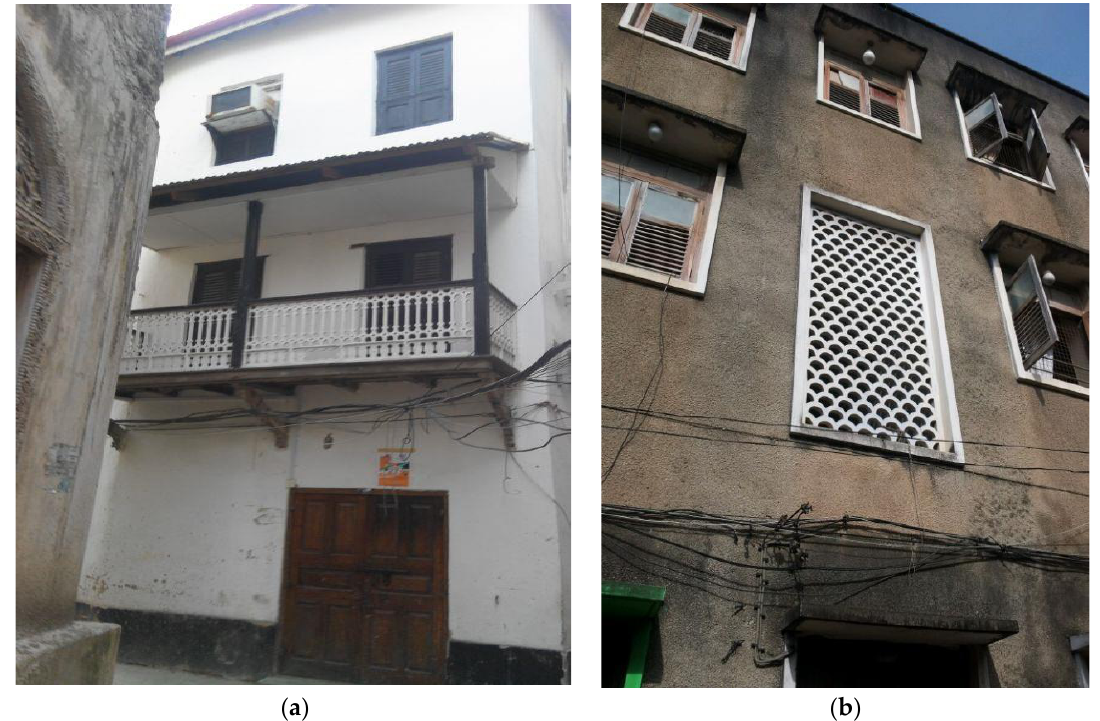
Figure 1. Case study of historical residential buildings. ( a ) HRB1, ( b ) HRB2.